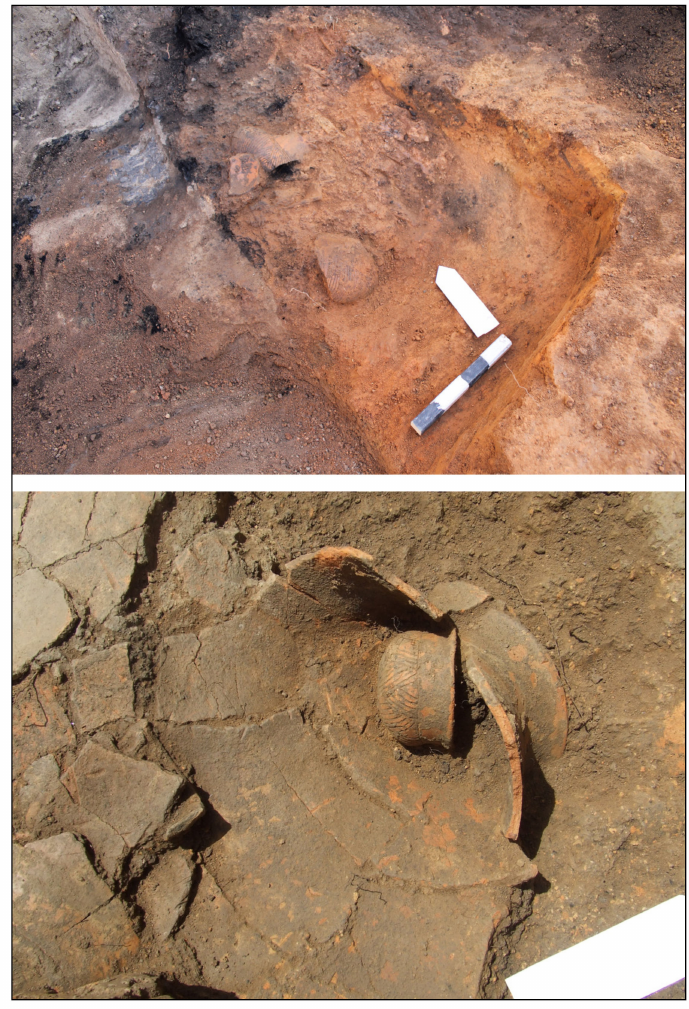
Figure 13. Burned layer and archaeological pottery “in situ” (Dragos